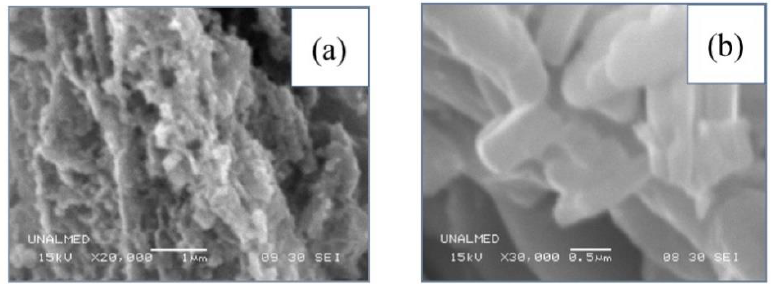
Figure 3. SEM images for Birnessite-type materials ( a ) Mn4 and ( b ) Mn8.